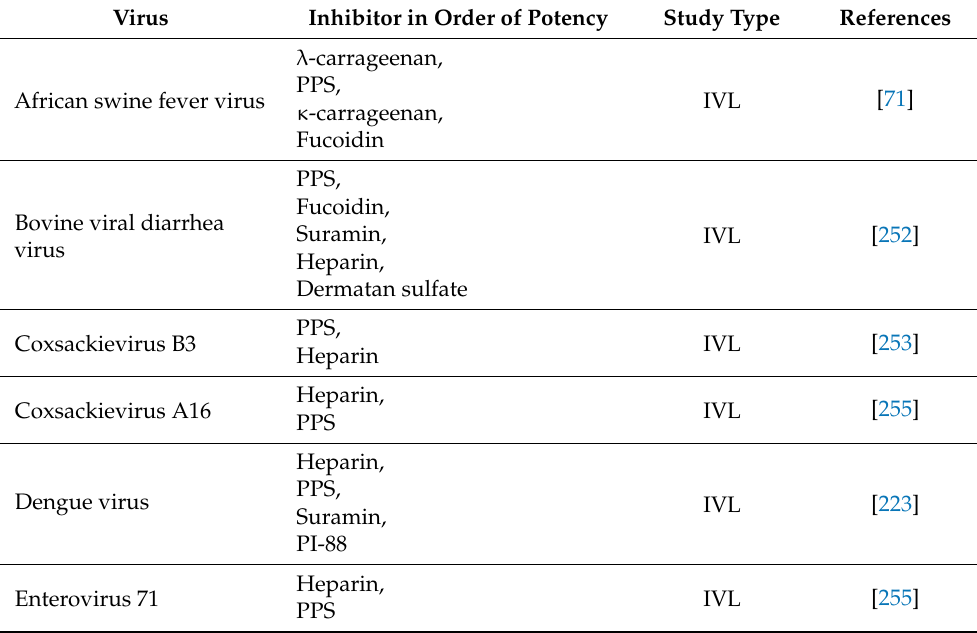
Table 2. Inhibition of viral attachment to host cells, viral infection and replication by sulfated